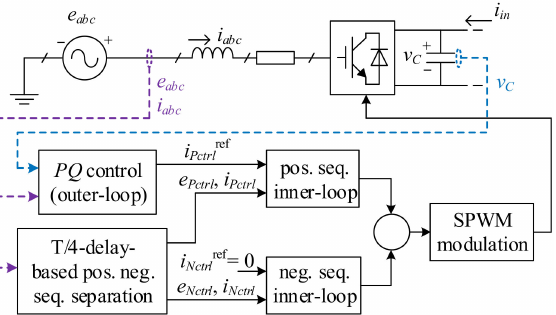
Figure 2. Control Structure of Three-Phase VSC under Unbalanced Grid